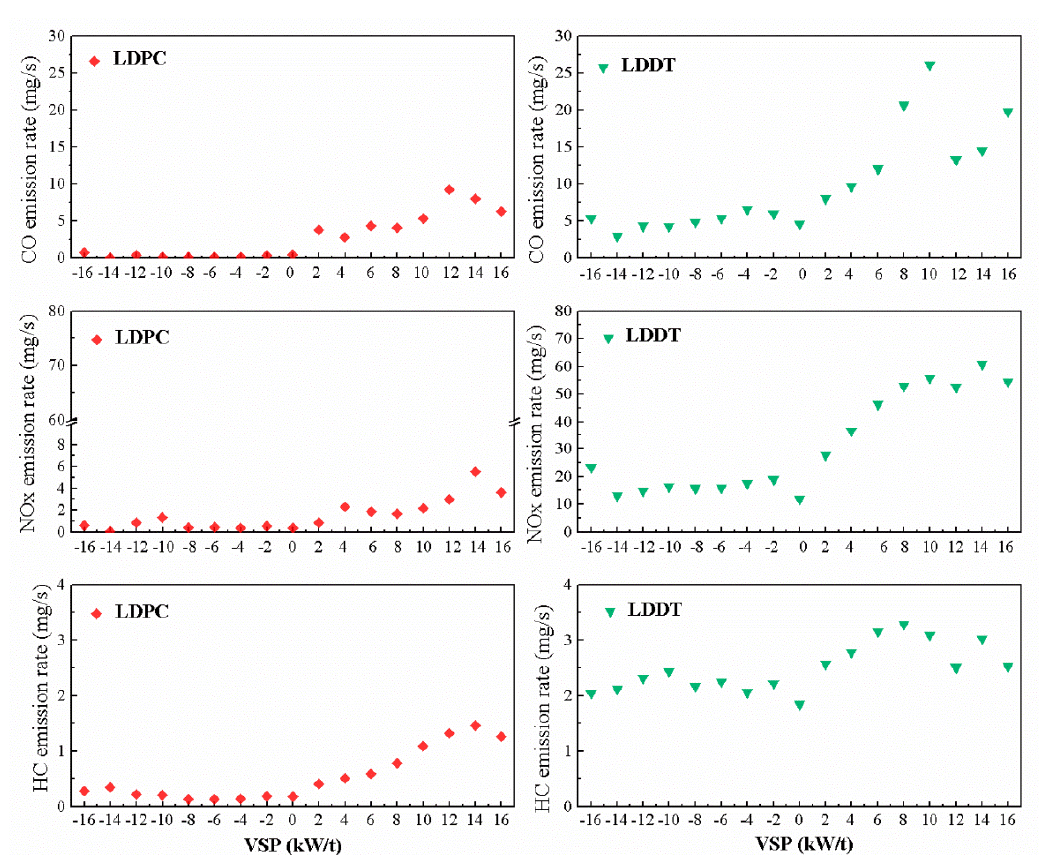
Figure 7. The relationship between the average emission rates of CO, NOx and HC and VSP.